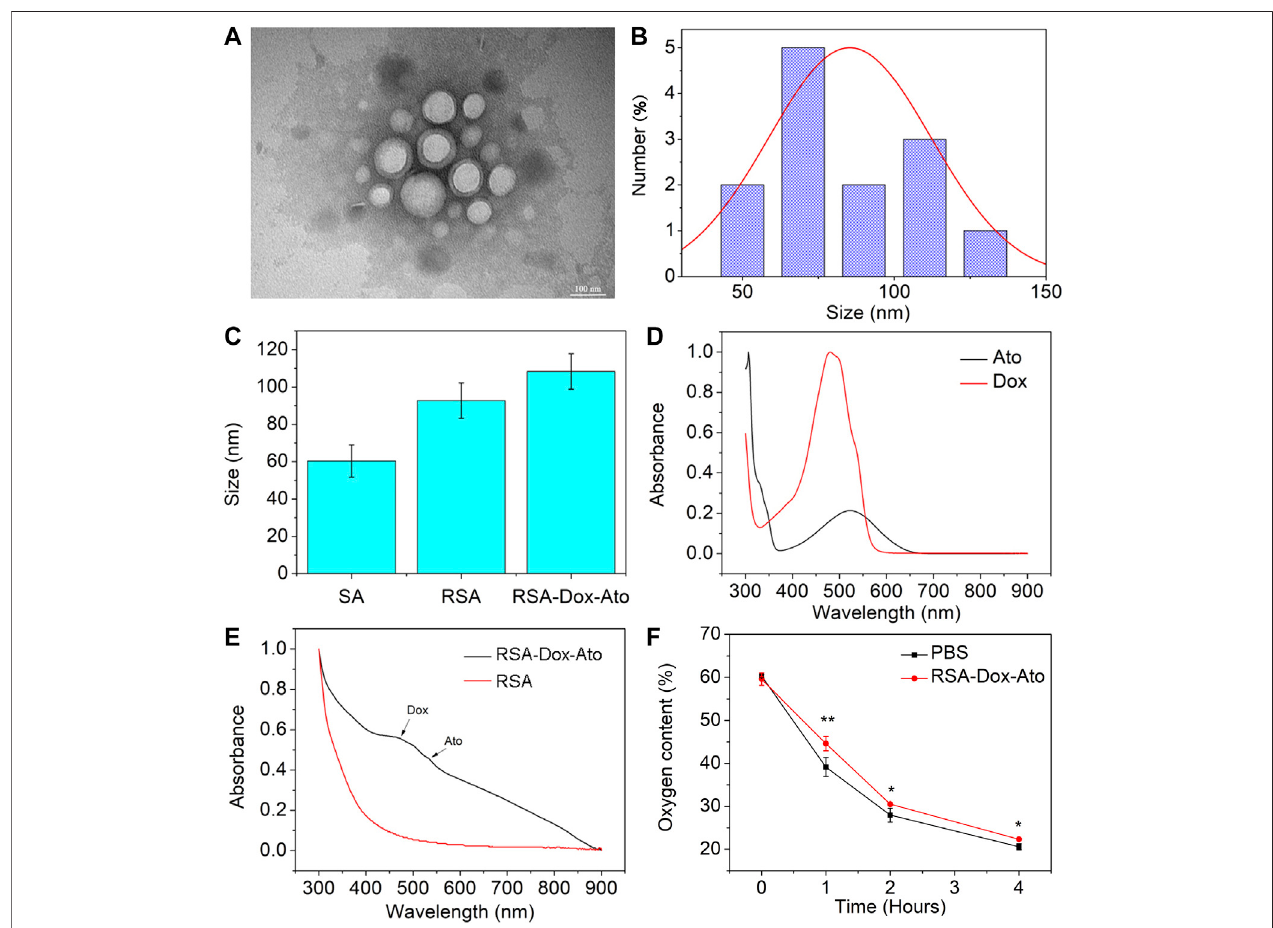
FIGURE 1 | Characterization of SF-based nanoparticles. (A) TEM images of the RSA-Dox-Ato NPs. (B) The size distribution of the RSA-Dox-Ato NPs; (C) The mean hydrodynamic diameter distribution of RSA NPs (92.67 ± 9.50 nm) and RSA-Dox-Ato NPs (114.67 ± 14.29 nm); (D) UV-vis spectra of Ato and Dox; (E) UV-vis spectra of RSA-Dox-Ato NPs and SA NPs; (F) Oxygen concentration in the cell medium after treatment with and without Ato under an anaerobic environment.